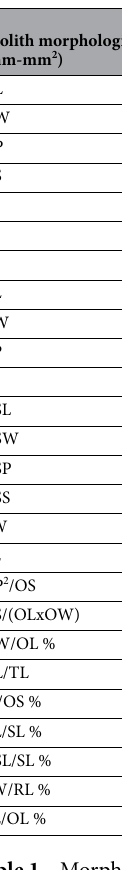
The P. bogaraveo specimens exhibited an elliptical otolith shape with crenate margins, developmentally increasing margin regularity, notch depth, and antirostrum length. The t-test performed on otolith morpho- metrical parameters did not reveal differences between the right and left sagittae in the two size groups analyzed (Supplementary Table S1). The differences between adults and juveniles were observed in the shape and size of the rostrum, the shape and borders of the ventral and dorsal margins, and the proportions of otolith length to fish length and otolith width to otolith length. In the otoliths of juveniles, dorsal and ventral margins were lobed, and the rostrum was shorter, broader, and rounder. The sulcus acusticus occupied a greater sagittal area compared to adult otoliths, with the cauda larger than the ostium. In adult specimens, the sulcus penetrated deeper into the sagitta’s car- bonate structure compared to juveniles. Significant differences were detected in sagitta aspect ratio (OW/OL %), sagitta length to total fish length ratio (OL/TL), and rostrum aspect ratio (RW/RL %) between juveniles and adults (Supplementary Table S1). As in P. bogaraveo, in P. acarne adult specimens, the sulcus acusticus penetrated deeper into the sagitta struc- ture (Figs. 2d–e; 4e–f). In the P. acarne specimens, significant differences in rostrum aspect ratio (RW/RL %) were detected between right and left sagittae (Supplementary Table S1). A significant negative correlation was found between sagitta aspect ratio (OW/OL %) and fish total length (TL), while a positive correlation was observed between relative sulcus area percentage (SS/OS %) and fish weight (Supplementary Table S2). The P. erythrinus specimens displayed a pentagonal otolith shape, highlighted by high rectangularity, with a high circularity value. In juvenile specimens, the rostrum and sagittal width increased in relation to fish length and weight, while the sagitta length values did not varied significantly between juveniles and adults, highlighting an exponential increase in fish length compared to sagittal length. In adult P. erythrinus specimens, the sulcus